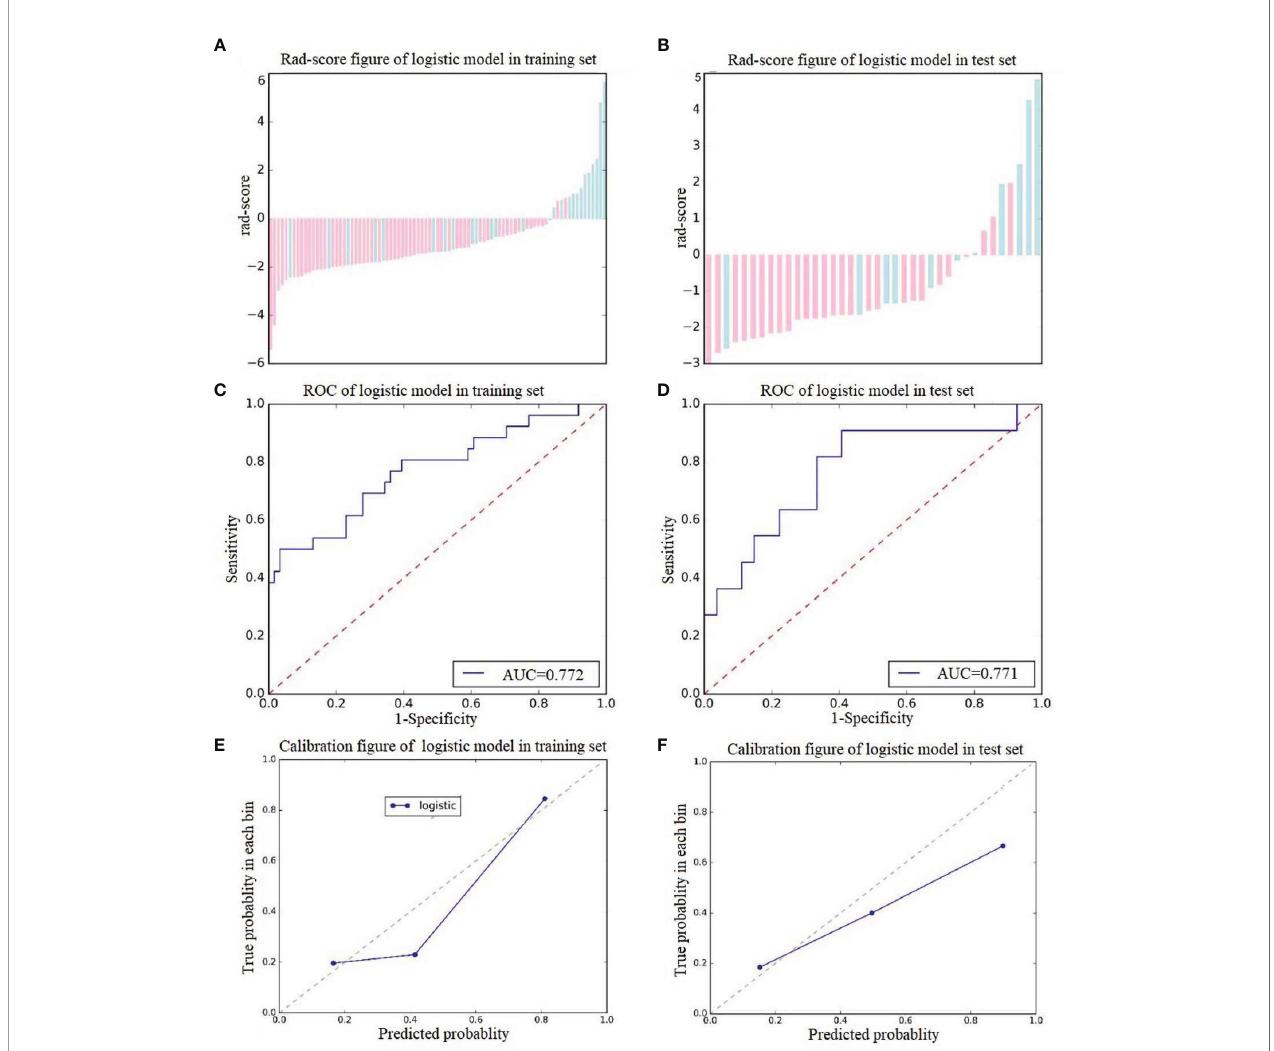
FIGURE 4 | Score diagrams of the radiomics signature in (A) the training set and (B) the test set. (C, D) show the diagnostic accuracy of the rad-score of the radiomics signature in the training and test groups. (E, F) show the calibration curve of the radiomics signature in the training and test